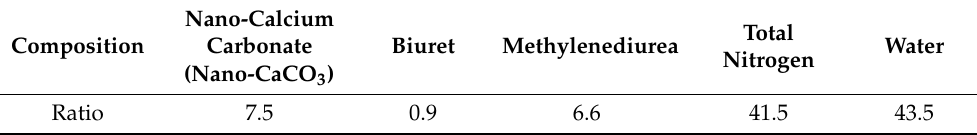
Table 2. Chemical composition of the planting concrete additive